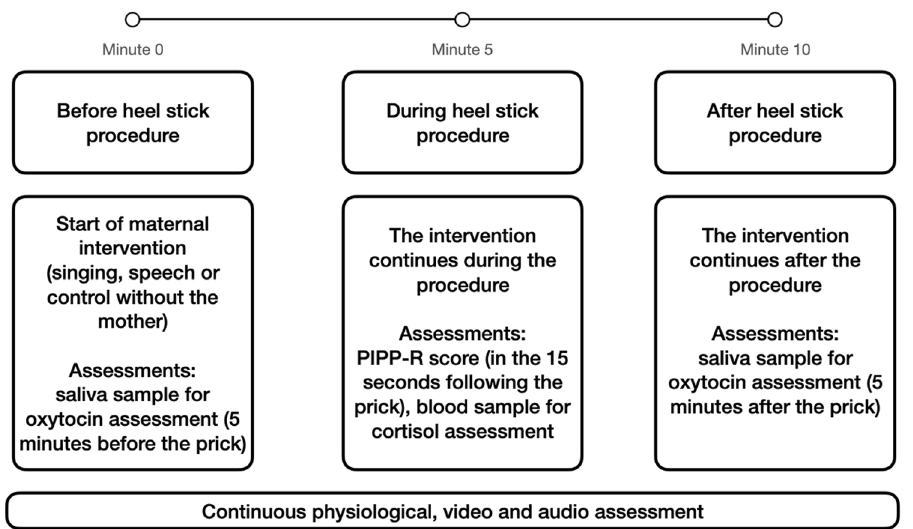
Figure 1. Procedure diagram of the sample collections, assessments and